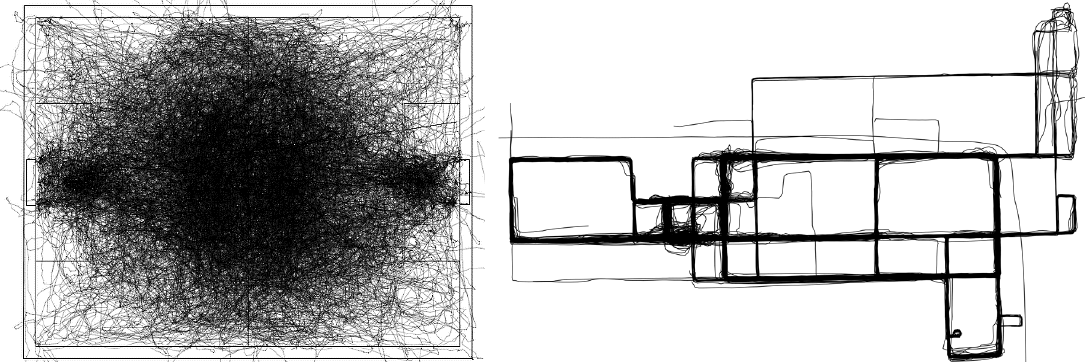
Figure 7. Left : The high accurate trajectories contained in the football dataset of the first experiment. Right : The car trajectories processed in the third experiment.